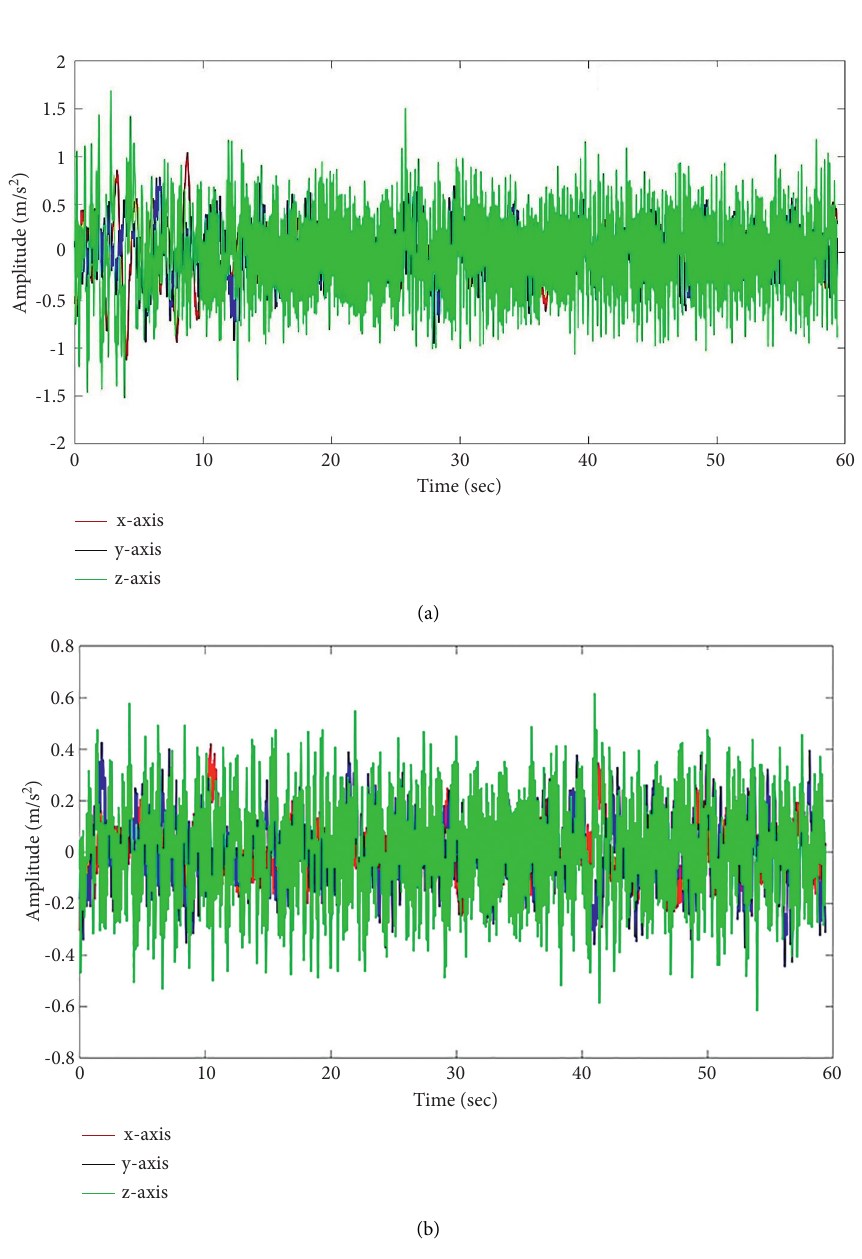
Figure 3: Mean time and amplitude response along the translational axes at (a) seat pan and (b) seat